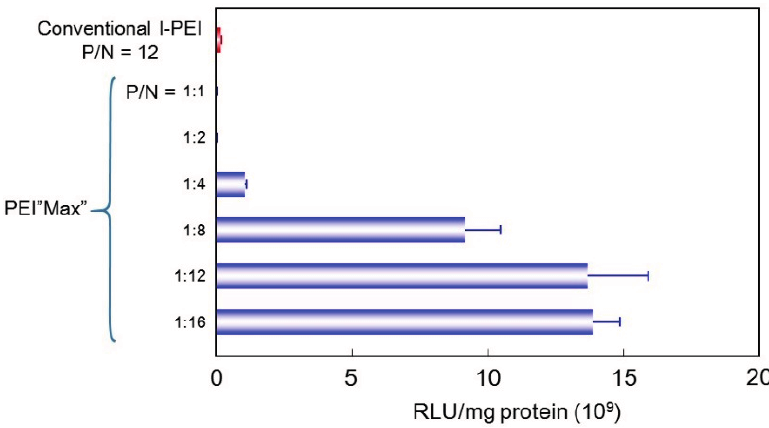
Figure 1. Effect of mixing ratio of DNA and PEI “Max” on the transfection efficiency.